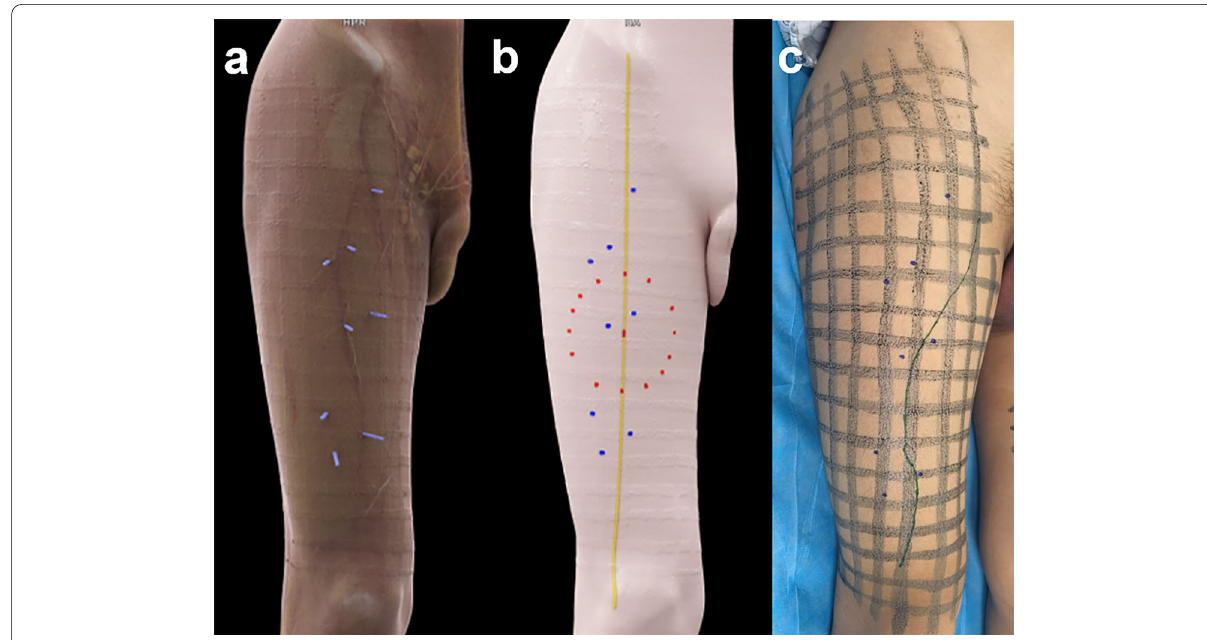
Fig. 2 CTA mapping for ALTPs. a Vertical projection of perforators by cinematic rendering reconstruction. b A diagram depicting the position distribution of perforators. The “hot zone” (red points) was an area of 5‑cm radius from the midpoint between the anterior superior iliac spine and the superior lateral boundary of the patella (yellow line); the location of perforators (blue points) was marked. c The course of the descending branch of the lateral femoral circumflex artery and the location of perforators drawn on the skin